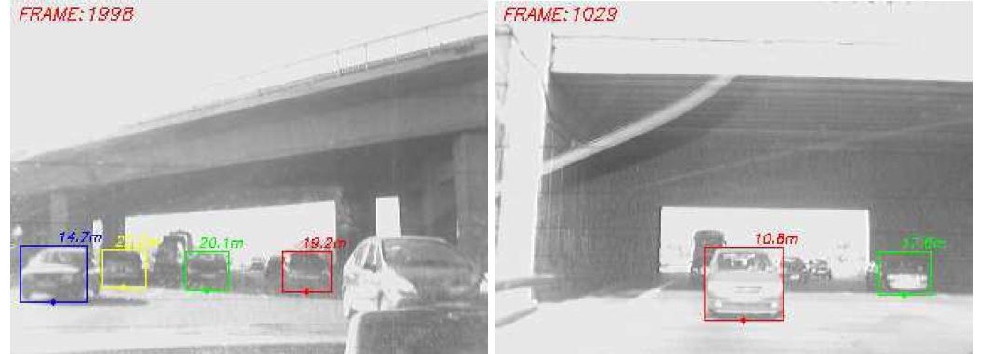
Figure 17. Examples with strong illumination changes after passing beneath a